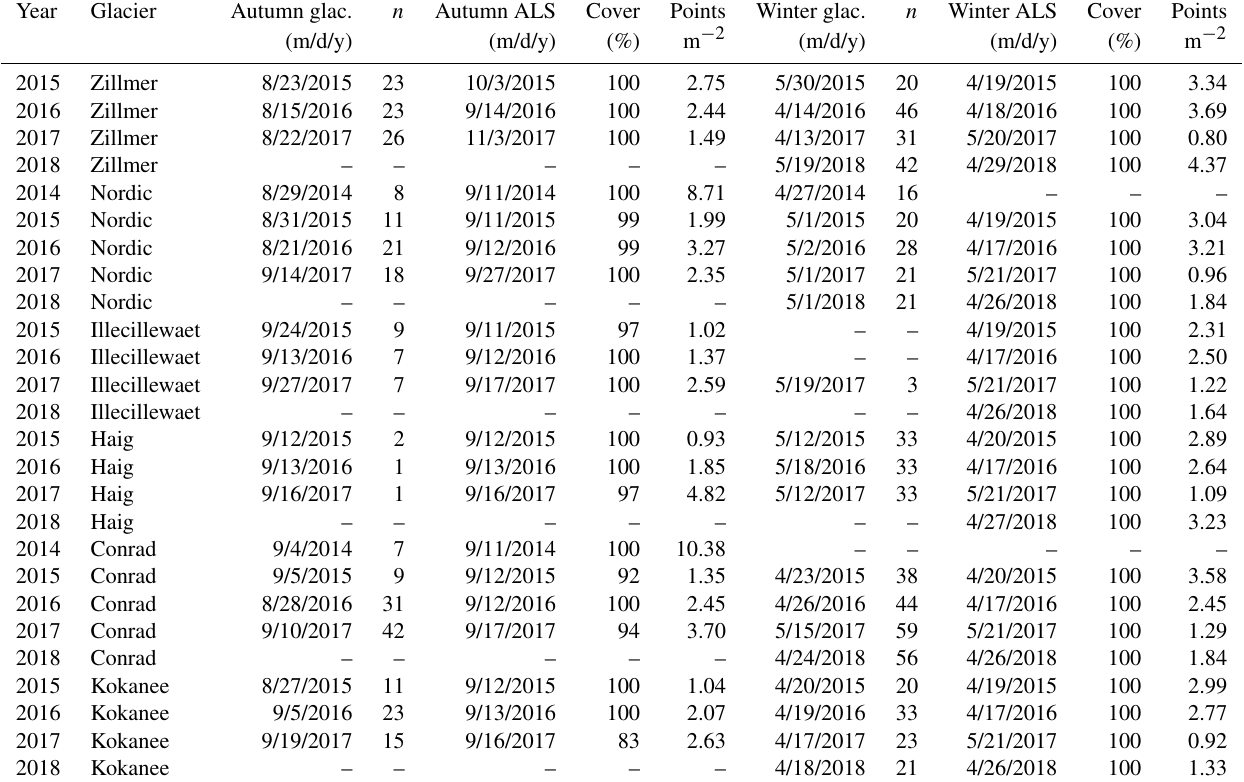
Table 2. Date and number of observation locations ( n ) for glaciological visits and geodetic acquisition dates and point density. Field dates are the median date of glacier